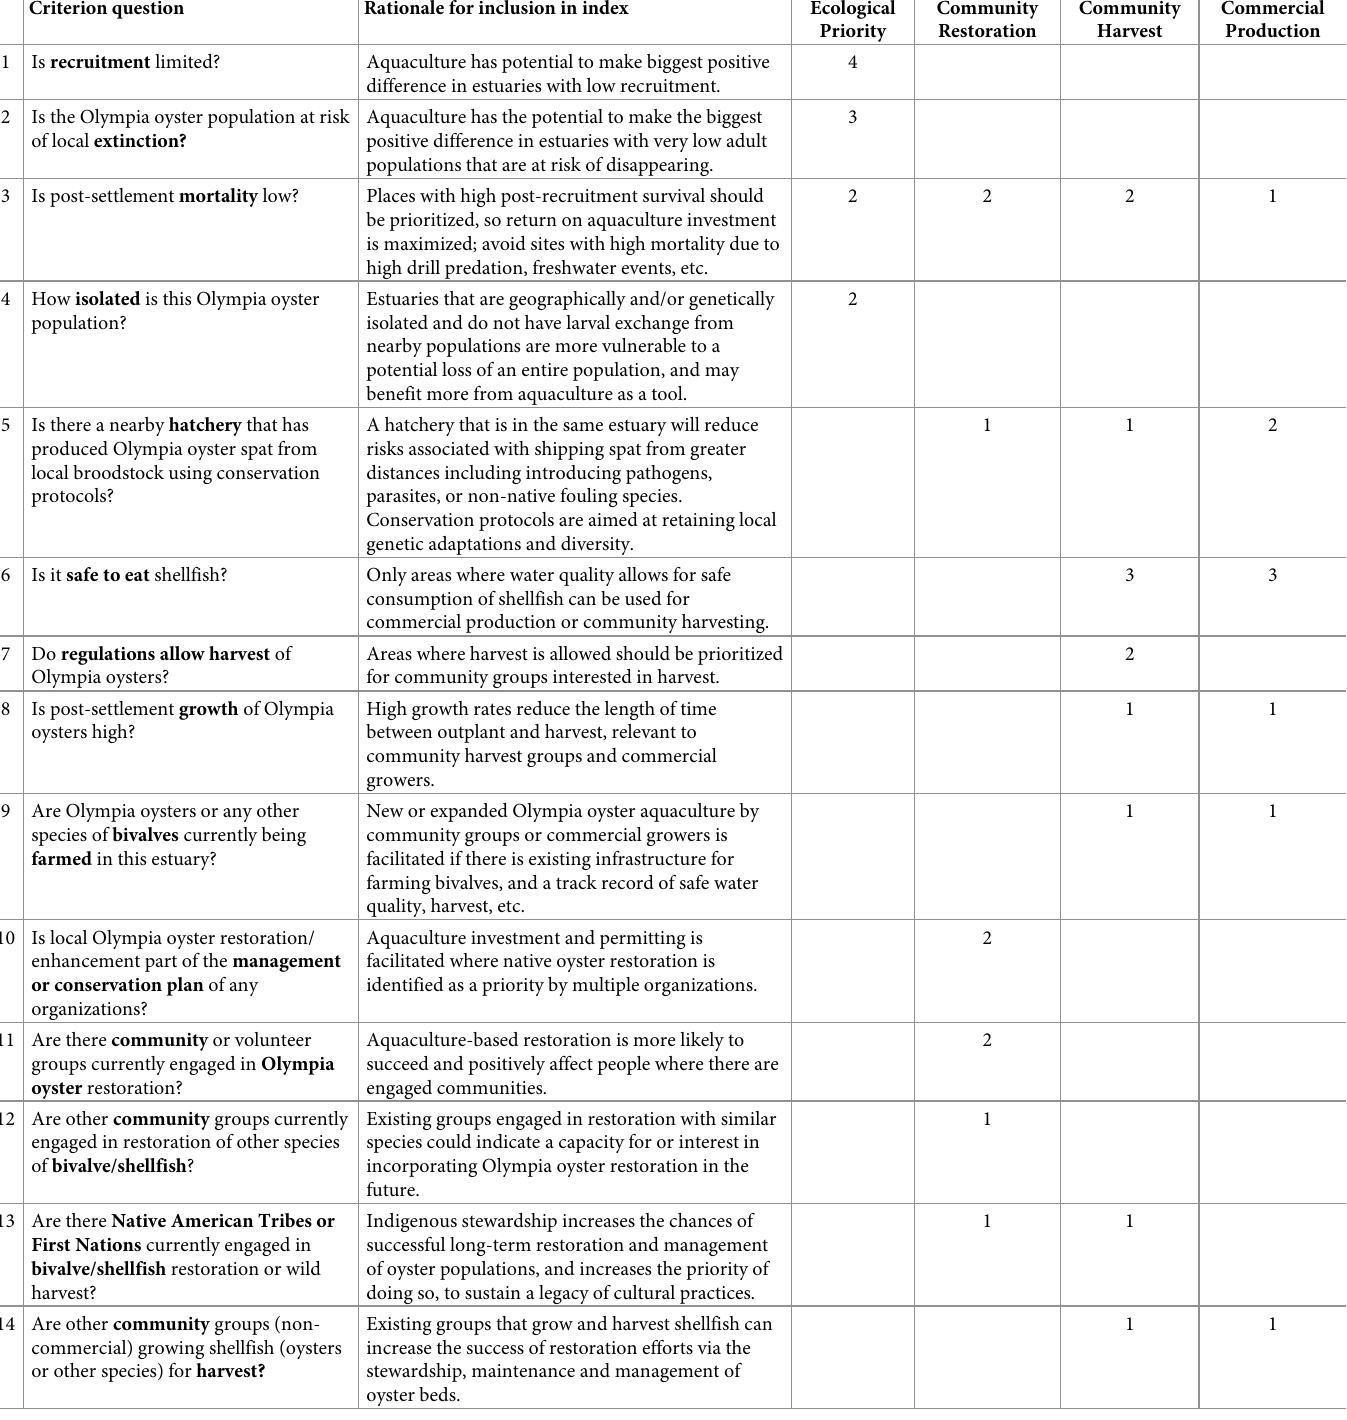
Table 1. Criteria used in evaluating estuaries for conservation aquaculture. Each criterion is framed as a question, and the rationale for inclusion is provided. In the final four columns, the weighting of each criterion used to calculate the four indices is shown; if blank, this criterion was not included in the index. Criterion